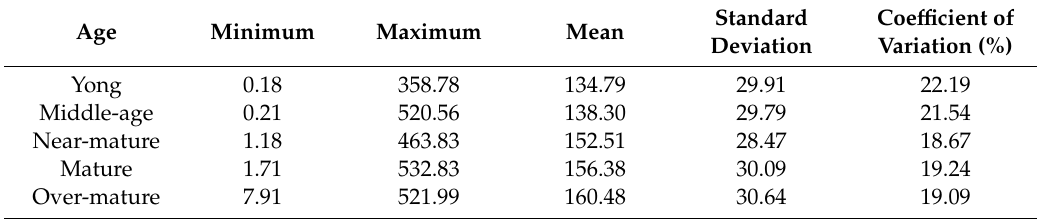
Table 5. Stand volume of forests with di ff erent ages in the study